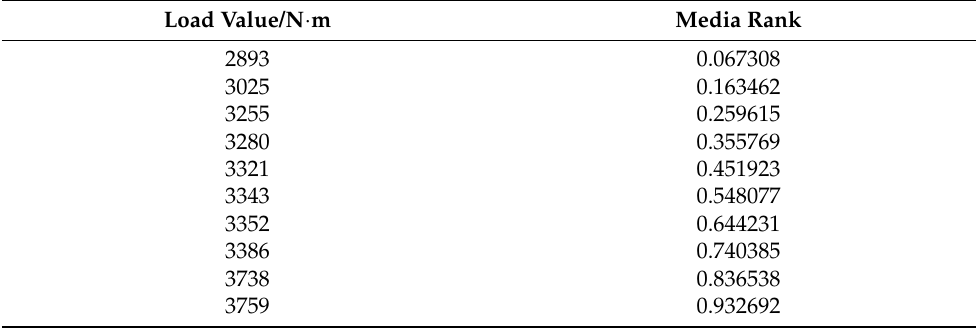
Table 8. The median rank (failure rate) estimation of the fatigue limit